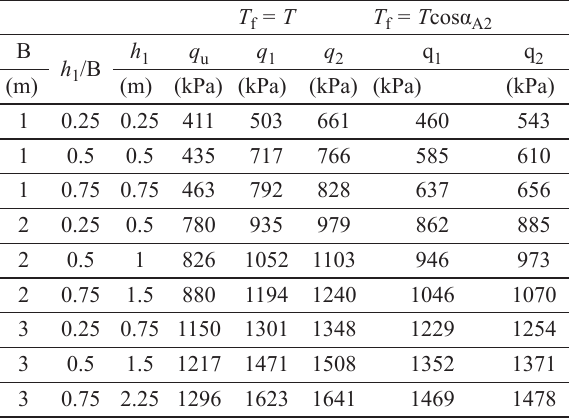
Table 5. Bearing capacity obtained from the new